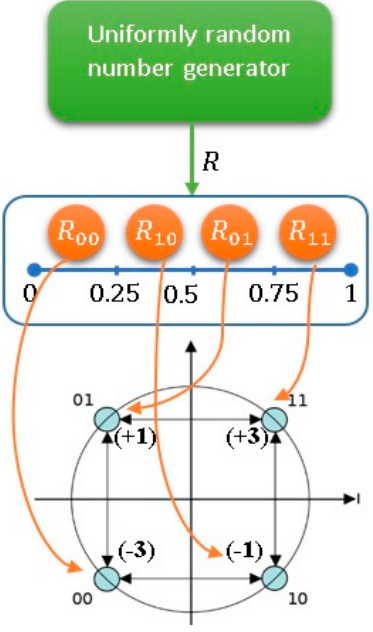
Figure 13. Four levels input scheme used to train FIR and IIR adaptive filters.